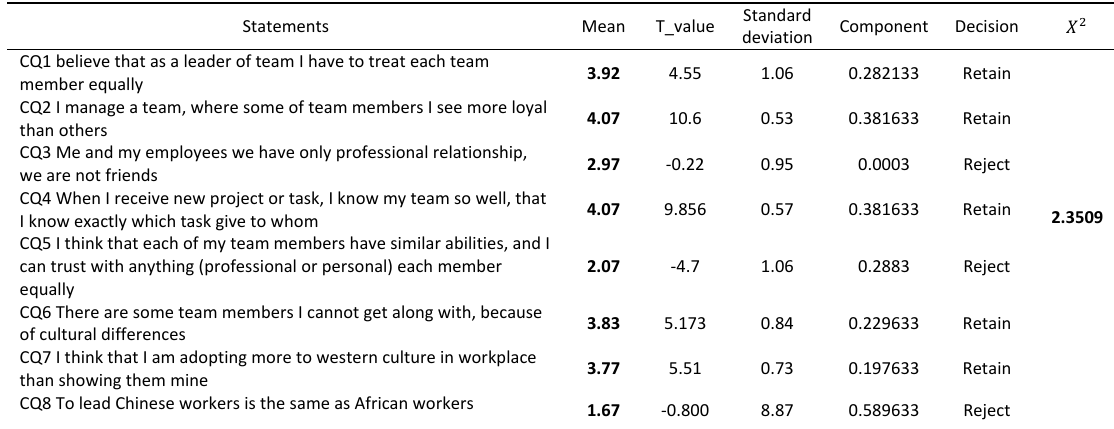
Table 6: Hypothesis testing for Chinese Supervisors